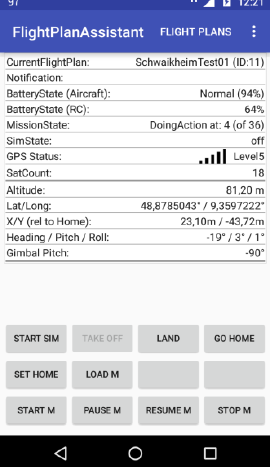
Figure 11. Screenshot of our flight assistant